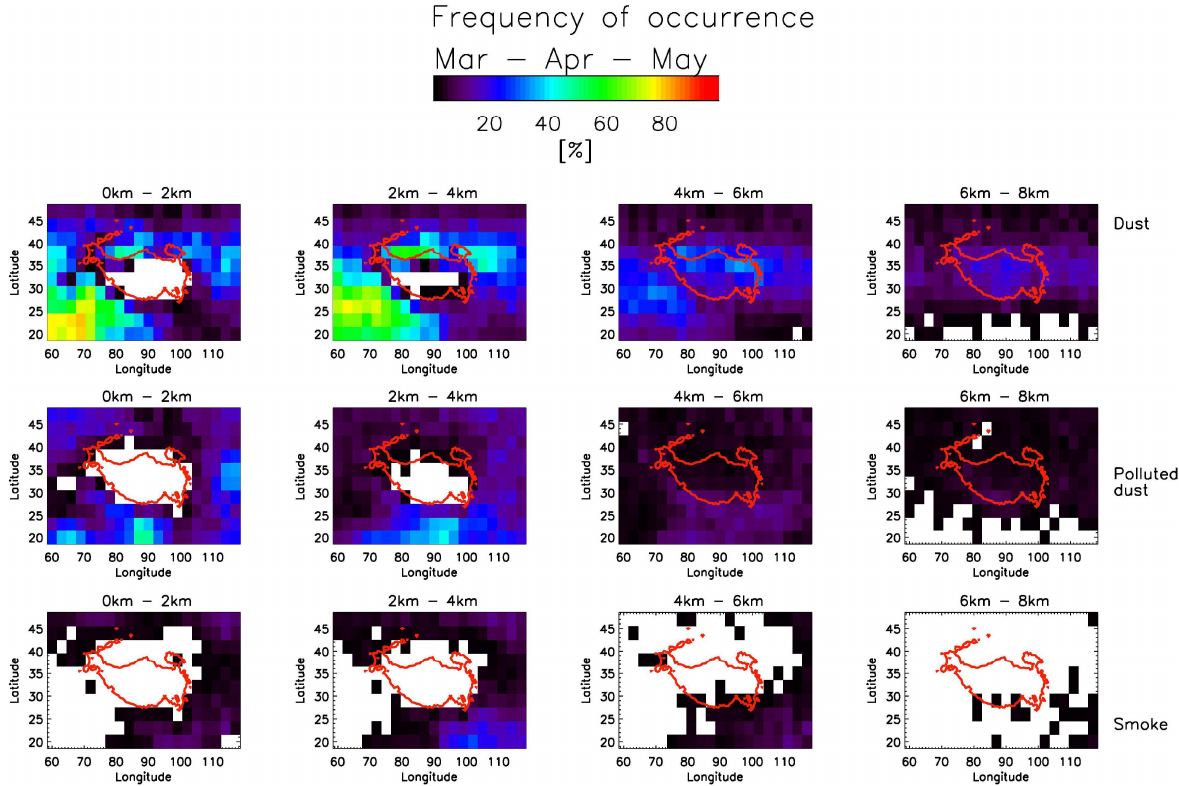
Fig. 2. As Fig. 1 but for MAM